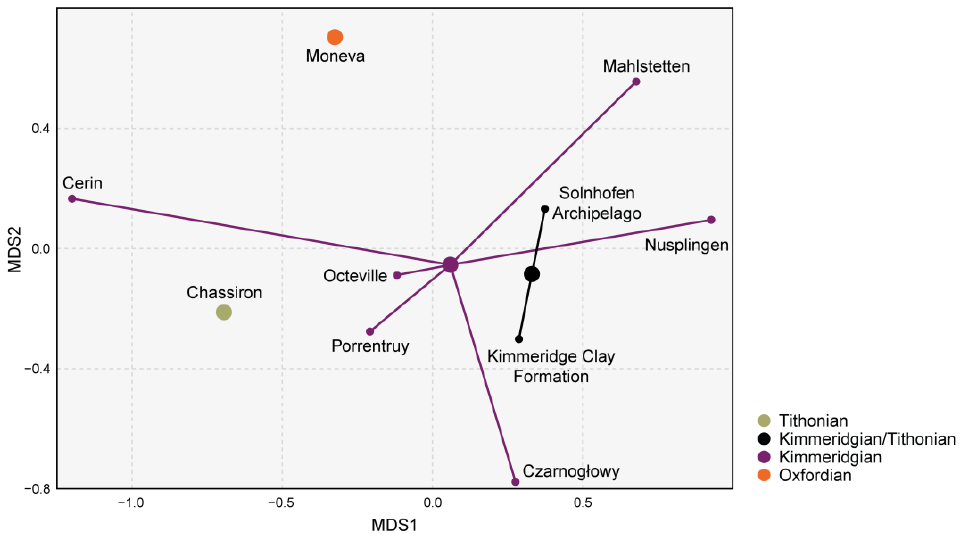
Figure 34. Multidimensional scaling dispersion plot, showing the dissimilarity relation between localities and geological times.